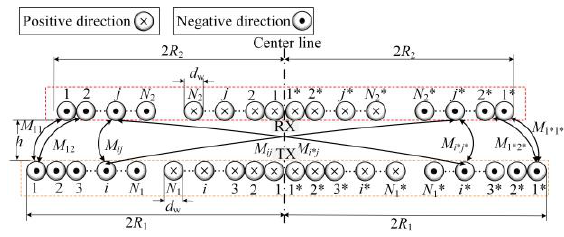
Figure 2. Half cross section of circular DD coils.